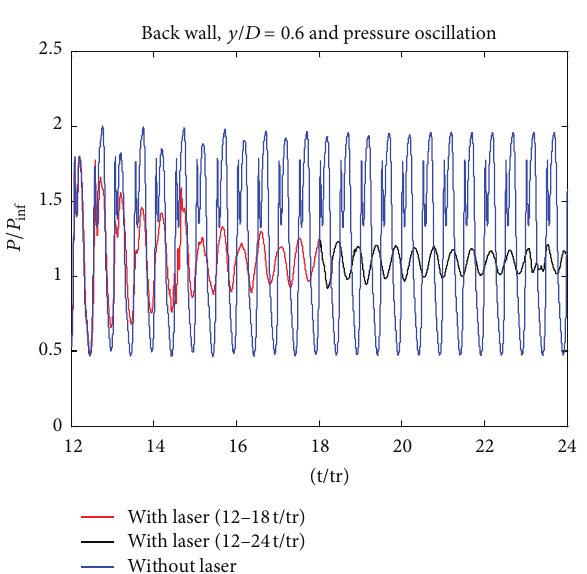
Cavity flow with laser, original data